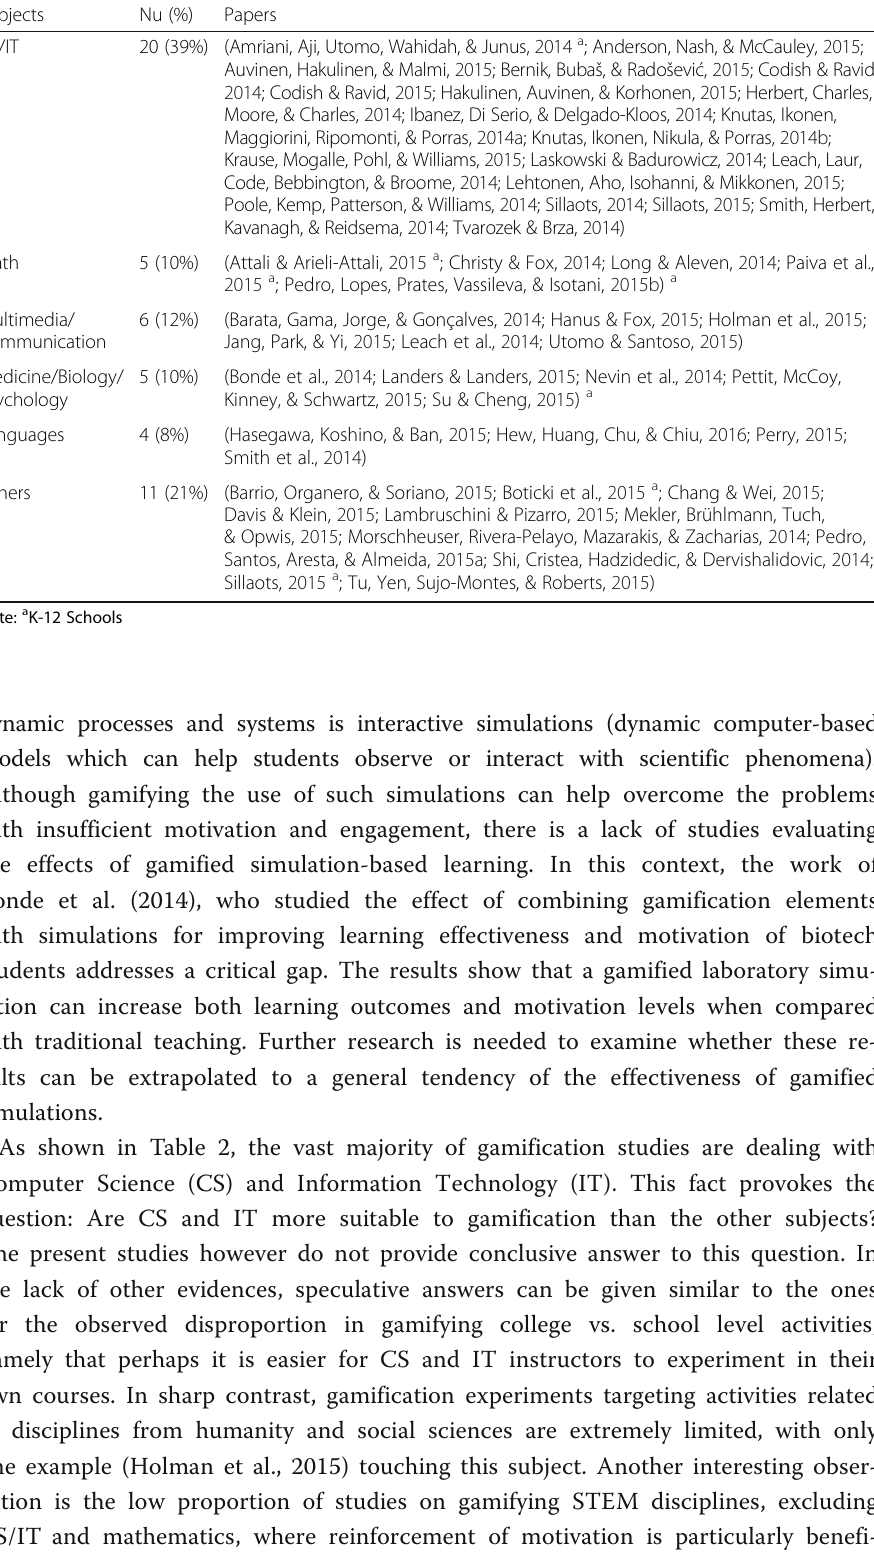
Table 2 Distribution of papers among subjects of studies Subjects Nu (%)